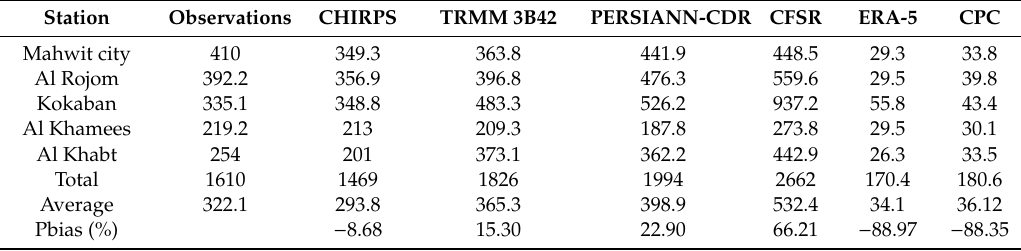
Table 8. Summary of the annual average of rainfall rates (mm) by the different products.